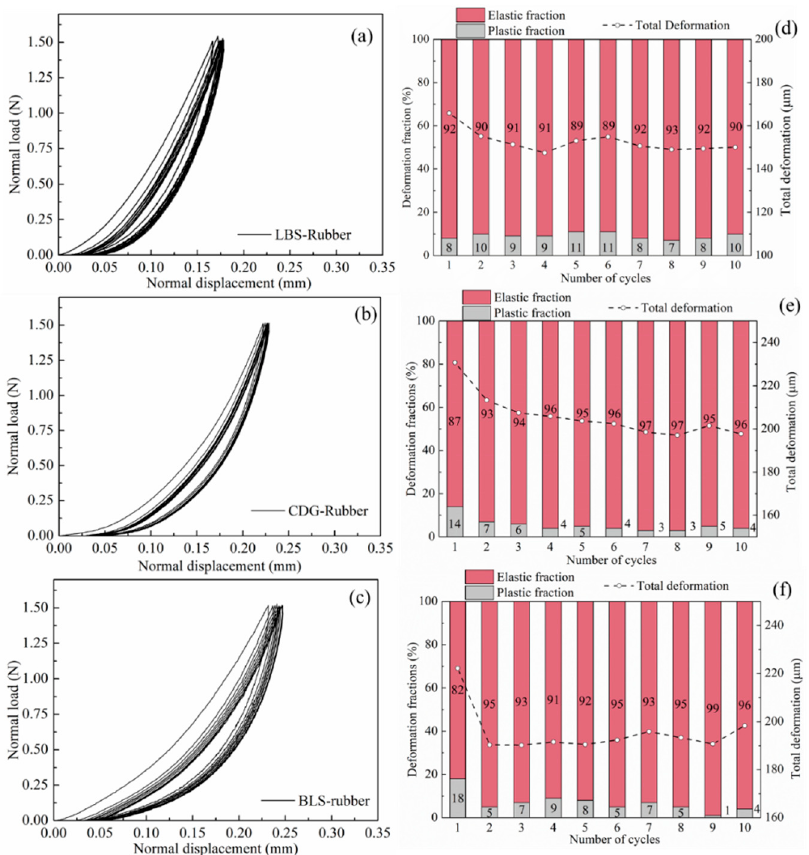
Figure 8. Load–displacement curves of cyclic loading for LBS–rubber, CDG–rubber, BLS–rubber ( a – c ) and coresponding displacement fractions ( d – f ).